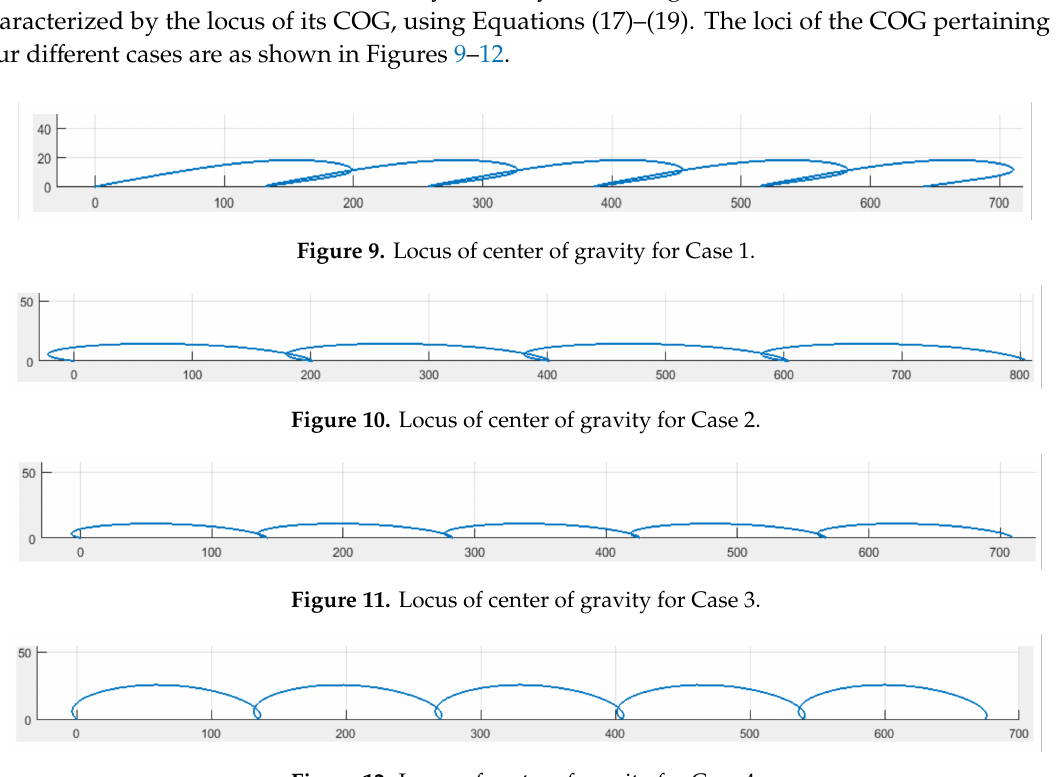
Figure 12. Locus of center of gravity for Case